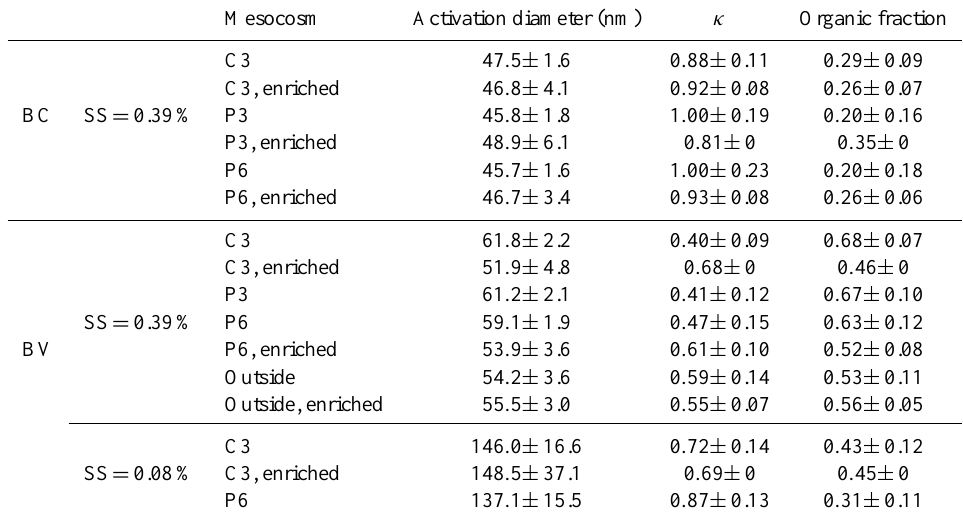
Table 3. Average activation diameters, κ values and organic fractions for both campaigns and